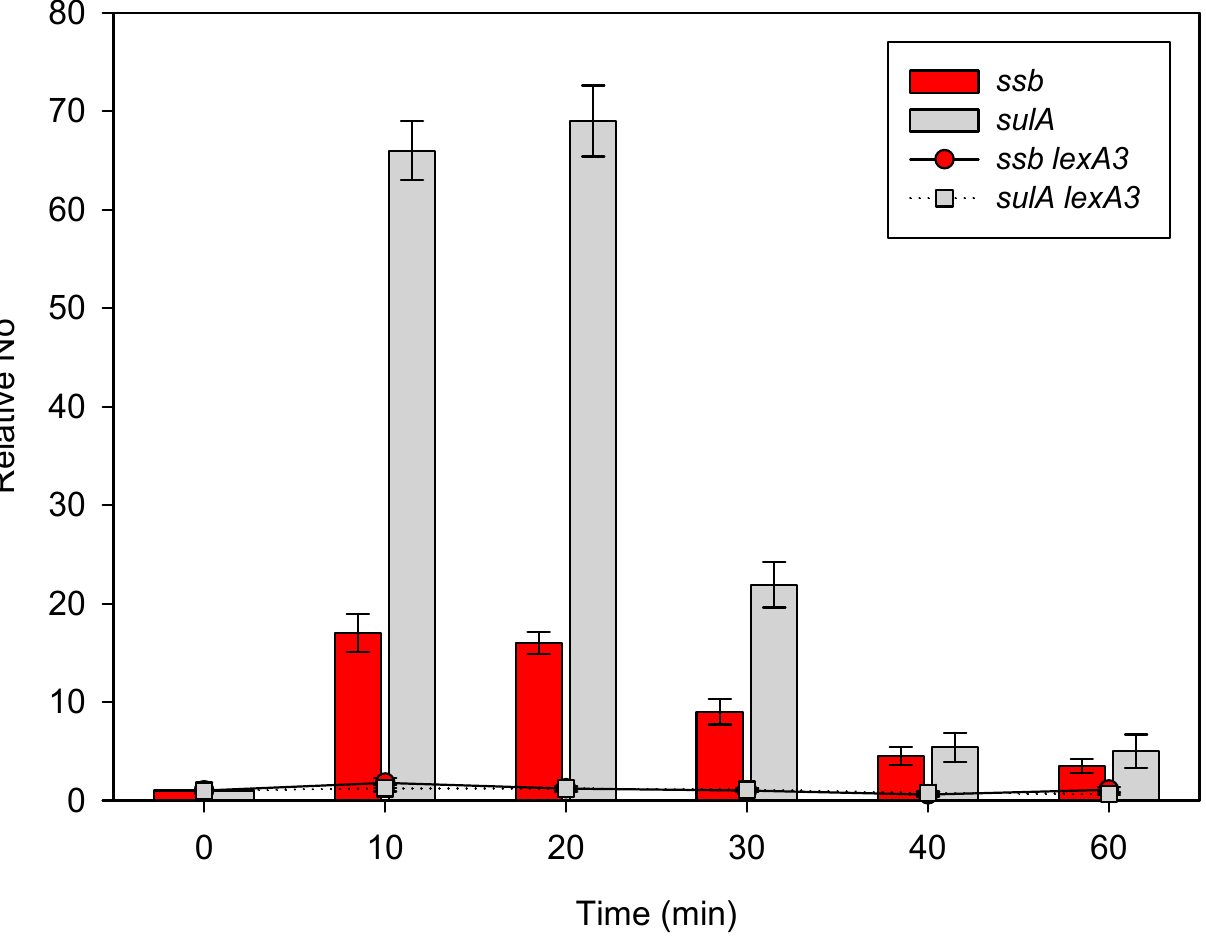
Figure 3. Expression of the ssb and the sulA gene in E. coli UV-irradiated with 40 Jm − 2 and incubated at 37 °C. Bacteria were irradiated when their exponential growth in LB medium reached OD 600 ∼ 0.4. Data are shown for wild-type bacteria (bars) and lexA3 (Ind − , SOS − ) (dots and lines) mutants. Bars and dots at time 0 represent unirradiated control. No represents normalized average No value for the two genes. Each value is a mean of the three independent qRT-PCR experiments, with error bars representing standard deviation.